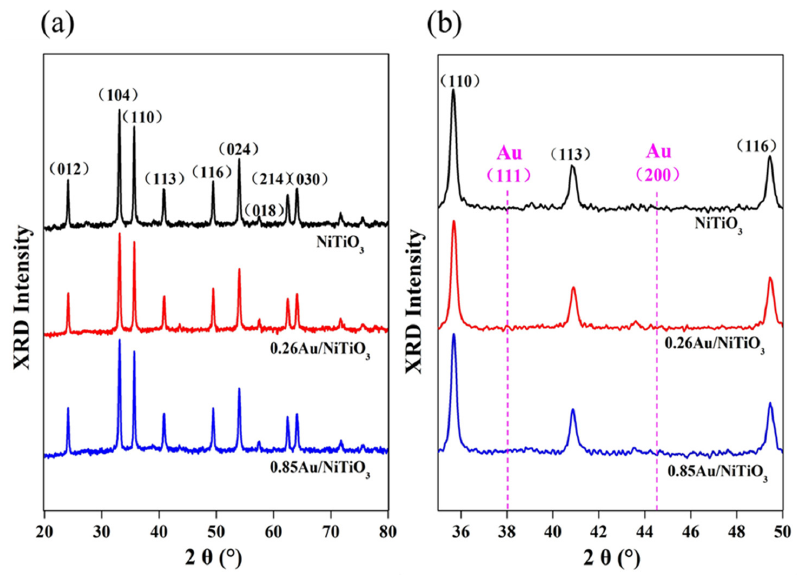
Figure 1. XRD patterns of the as-prepared NiTiO 3 and Au/NiTiO 3 samples obtained at 2 θ = 20–80° ( a ) and 2 θ = 34–50° ( b ). Figure 2 shows the SEM and TEM images of the as-prepared NiTiO 3 and Au/NiTiO 3 samples. As seen in the SEM images (Figure 2a,b) and TEM image (insert in Figure 2b), the as-prepared NiTiO 3 consists of rods of micron lengths, formed by self-assembled nanocrystals of less than 100 nm. The rods appear to be highly porous.